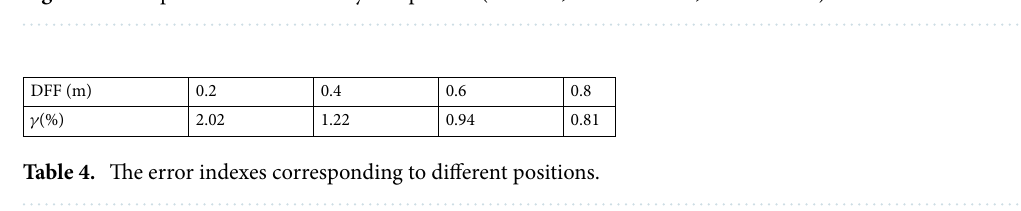
Figure 10. Displacement time history comparison (SRR is 4, SNR is 100 db, DFF is 0.2 m).